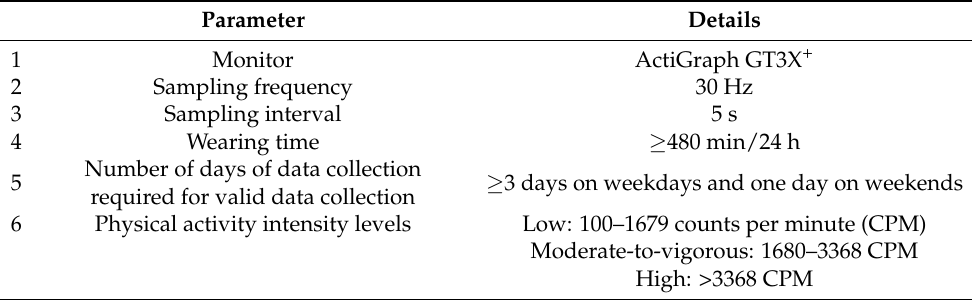
Table 1. ActiGraph GT3X + parameters.